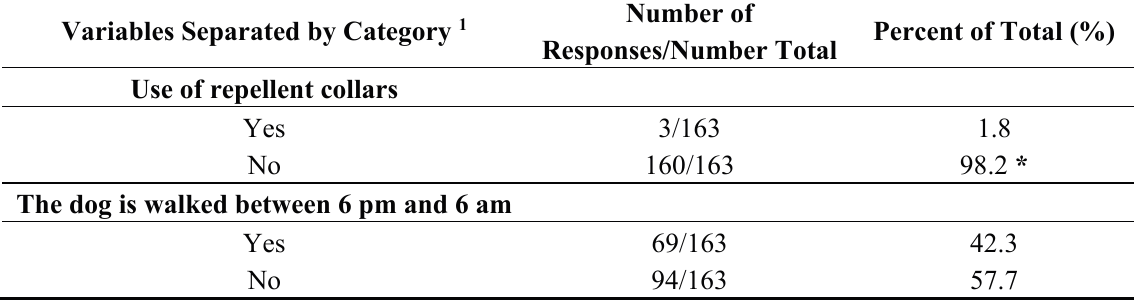
Table 5. Methods of protecting dogs against sand fly bites in areas near the Mossoró River, in the neighborhoods of Ilha de Santa Luzia, Alto da Conceição and Paredões in the city of Mossoró, Rio Grande do Norte,